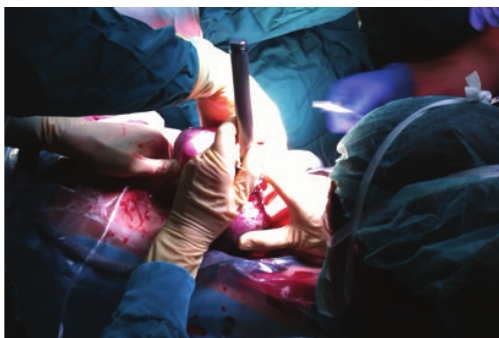
Figure 6: Fetal intubation time during